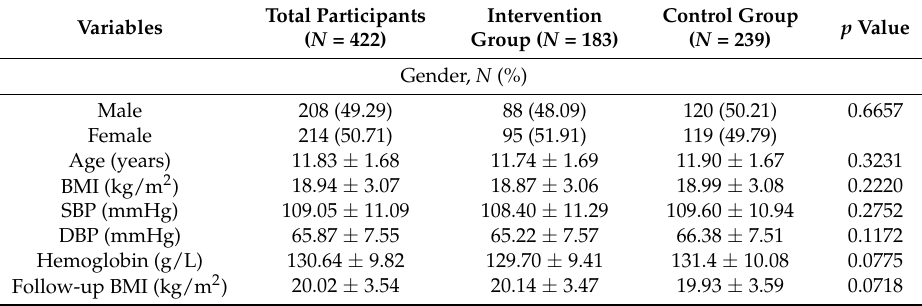
Table 1. Characteristics of the intervention and control groups in school children.